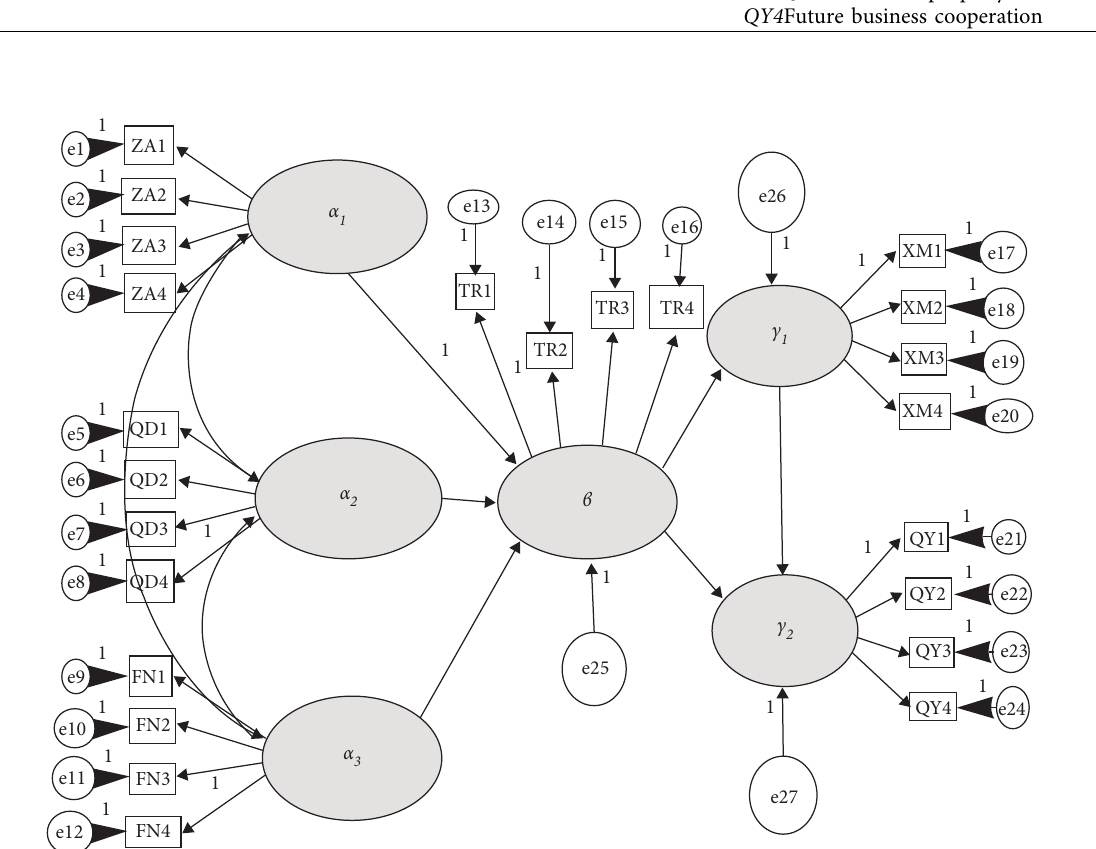
Figure 2: Structural equation model of the mechanism of influencing factors on